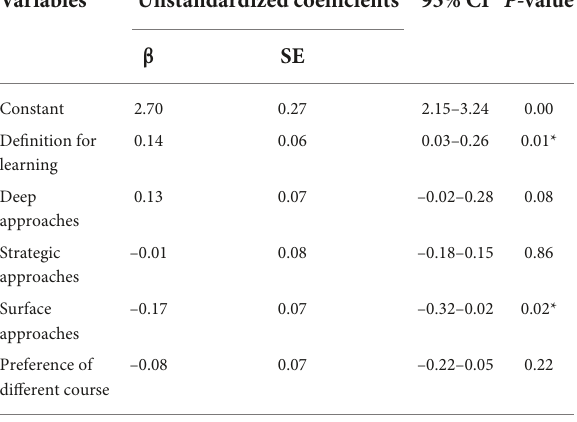
TABLE 5 The relationship between anesthesia students’ learning approaches and academic achievement [grade point average (cGPA)] at Debre Tabor University (DTU) and University of Gondar (UoG),